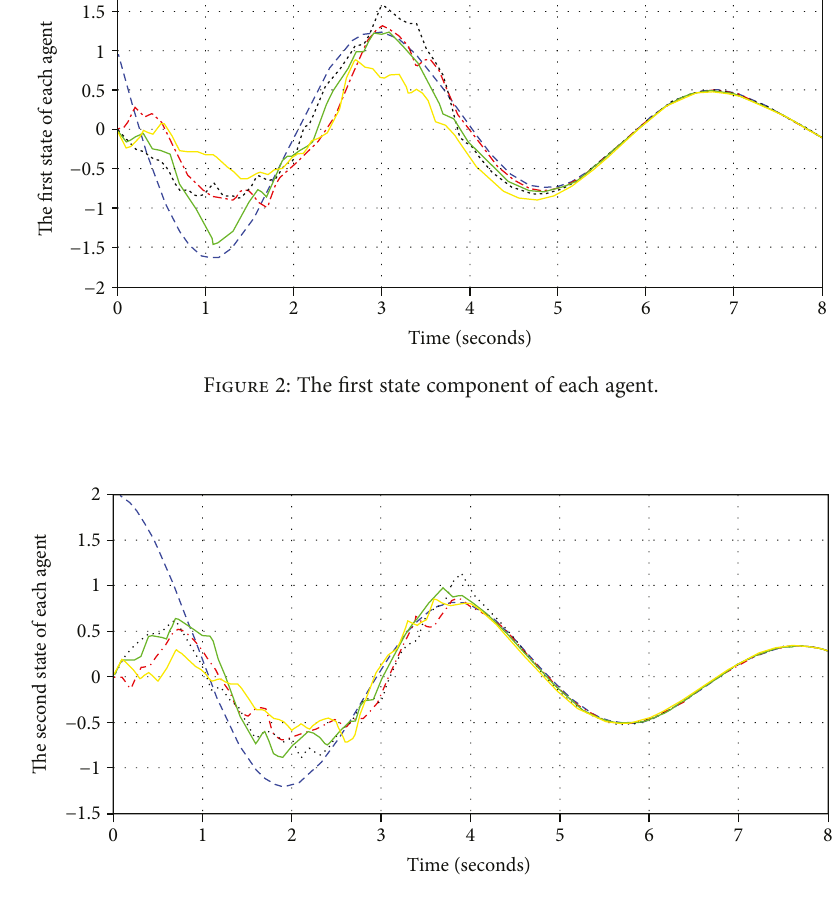
Figure 3: The second state component of each